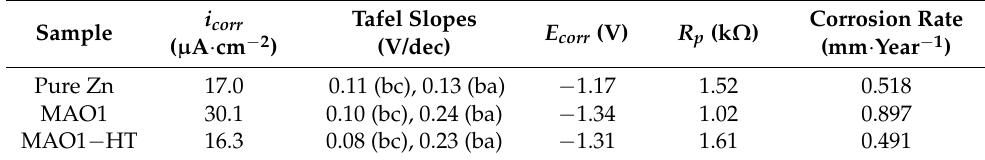
Figure 4. ( a ) OCP versus time and ( b ) polarization curves and ( c ) Nyquist plot of the uncoated and coated Zn. ( d ) equivalent circuit of MAO1 − HT, ( e , f ) Bode plots. Table 2. The results of potentiodynamic polarization test in SBF